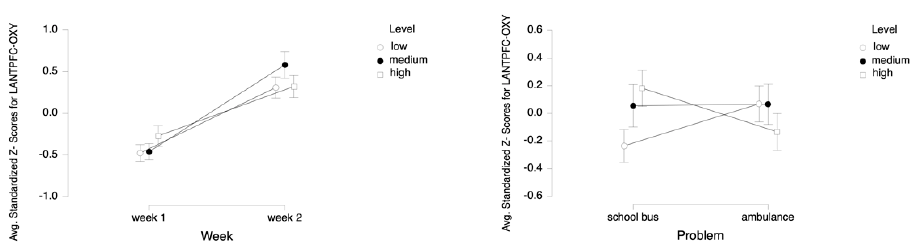
Figure 15. Bar charts represent the average standardized z-scores for oxygenation for right dorsolateral prefrontal cortex (Z-RDLPFC-OXY) and standard deviation (SD) for low cognitive load, medium cognitive load, and high cognitive load tasks for School Bus (left) and Ambulance (right) problem scenarios for Week 1 and Week 2.